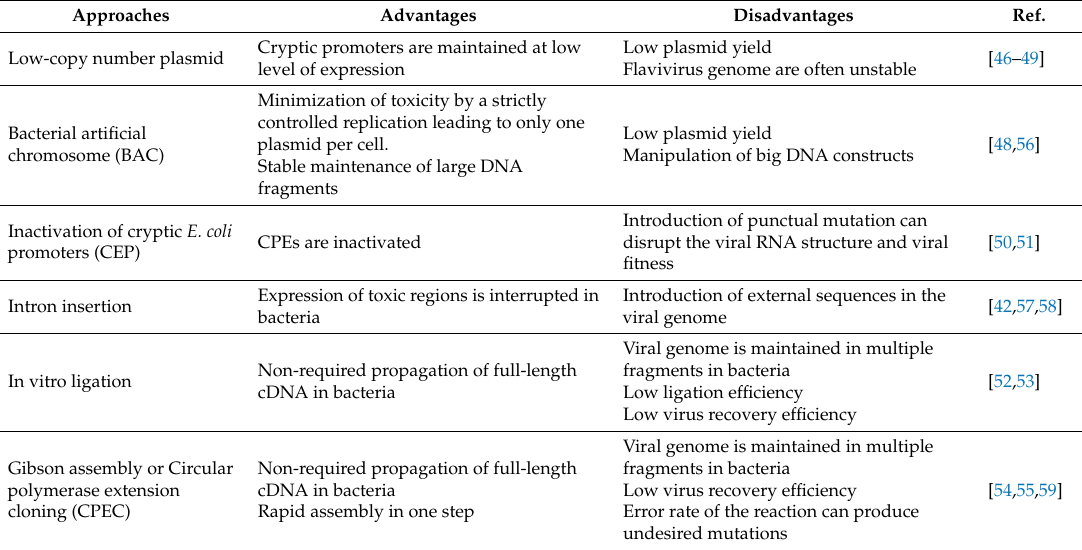
Table 2. Strategies to avoid toxicity of full-length